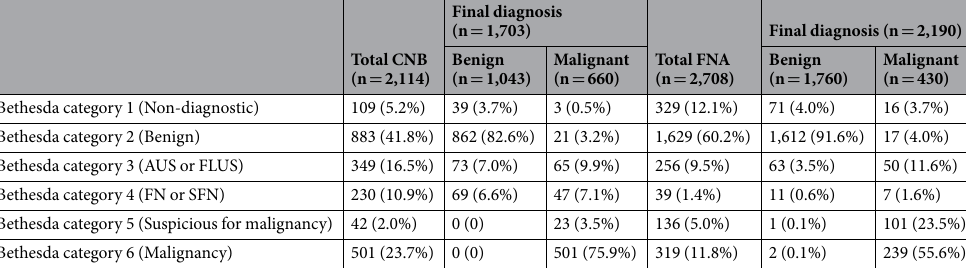
Table 2. CNB and FNA results and final diagnosis for initially detected thyroid nodules. Data are number of nodules. Percentages do not add up to 100% because of rounding. AUS = atypia of undetermined significance, FLUS = follicular lesion of undetermined significance, FN = follicular neoplasm, SFN = suspicious for a follicular neoplasm.